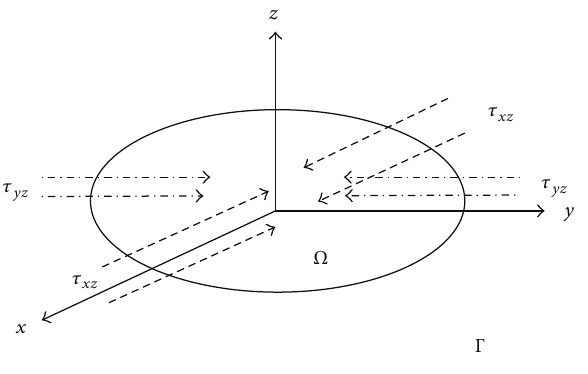
Figure 1: Stresses acting on a